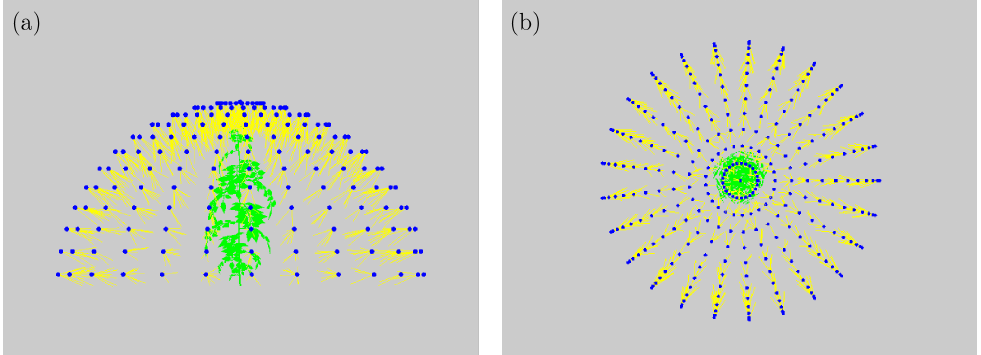
Figure 3. Top- ( a ) and side-view ( b ) of the virtual scanner hemisphere with the synthetic 3D tomato plant model in the centre of the scene. Blue spheres indicate the position of spatial points from where the 3D scanning is performed. The scanning sphere consists of 13 layers with 25 measuring points on each layer, resulting in 325 measuring points used for each scan. The thin yellow lines—length set to 30 centimetres for visualization only—represent a small fraction of the rays used for the